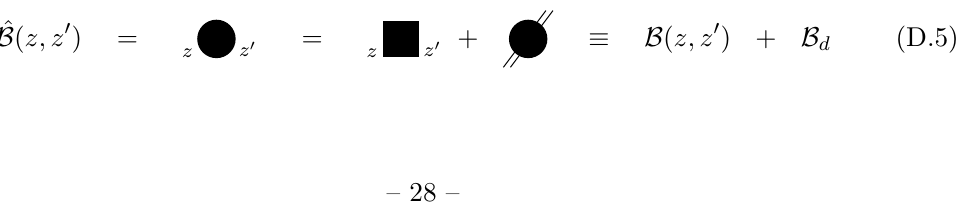
~φ 2 = 3 u . Bottom: diagrammatic representation of the = 3 λ 0 | 2 2 N |